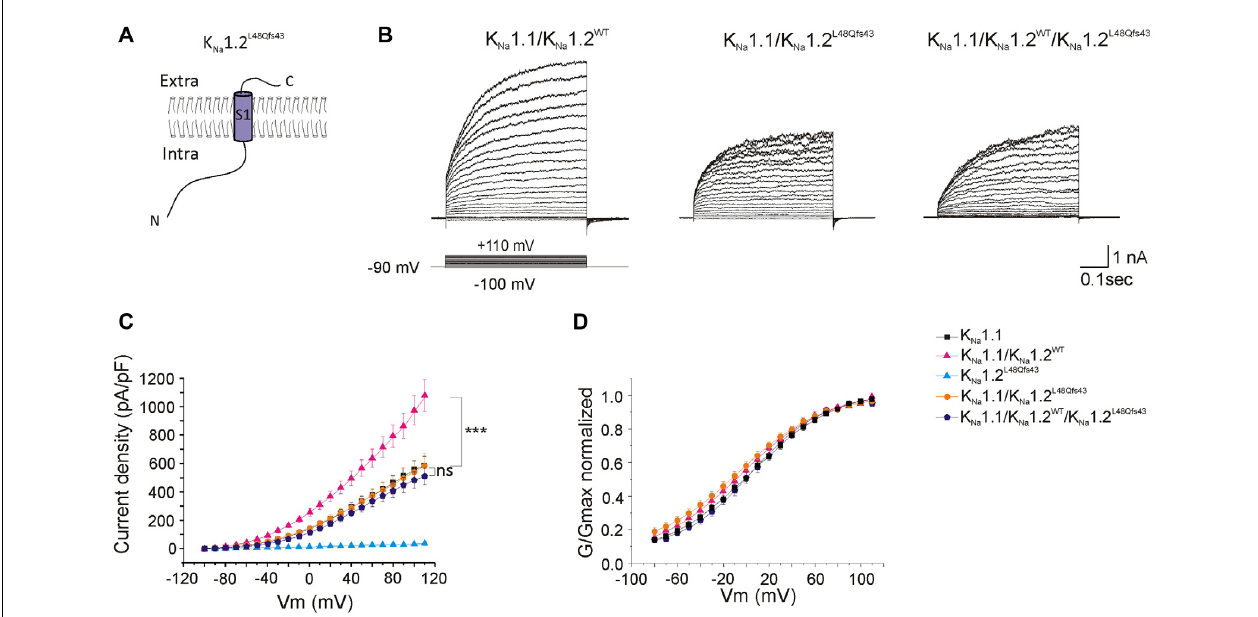
FIGURE 6 | Functional consequences of the p.L48Qfs43 mutation on heteromeric channels. (A) Schematic representation of the expected K Na 1.2 L48Qfs43 mutant subunit. The frameshift mutation locates in the N-terminal part of the protein, leading to predicted protein composed of the N-terminal domain and of transmembrane segment S1. (B) Representative current responses to depolarizing voltage steps in CHO cells transfected with K Na 1.1 + K Na 1.2 WT (left traces); K Na 1.1 + K Na 1.2 L48Qfs43 (middle traces); K Na 1.1 + K Na 1.2 WT + K Na 1.1 L48Qfs43 (right traces) plasmids. (C) Current densities measured in these three conditions but also including K Na 1.1 and K Na 1.2 WT for comparison. Corresponding symbols are indicated on the top of the graph. (D) Conductance-voltage relationship of wild type homomeric K Na 1.1; wild type heteromeric K Na 1.1 + K Na 1.2; heteromeric mutant K Na 1.1 + K Na 1.2 L48Qfs43 and heteromeric mutant K Na 1.1 + K Na 1.2 WT + K Na 1.2 L48Qfs43 channels normalized. Two-way ANOVA with Tukey’s correction for multiple comparisons. *** p < 0.001; ns, not